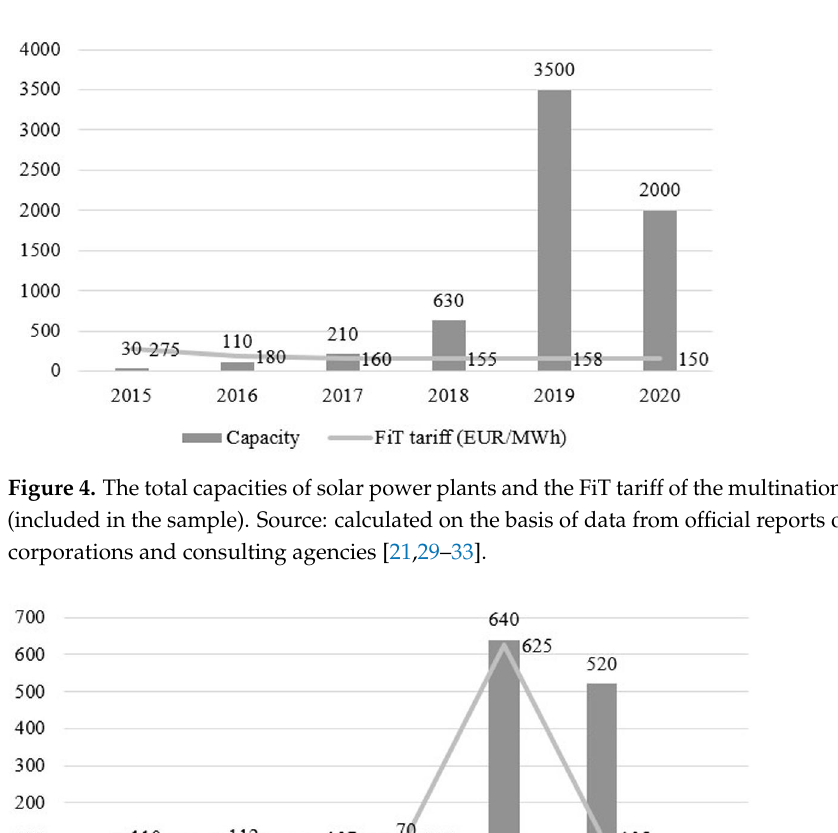
Table 1. Results of analyzing baseline scenarios for the development of corporate renewable energy industry. Scenarios